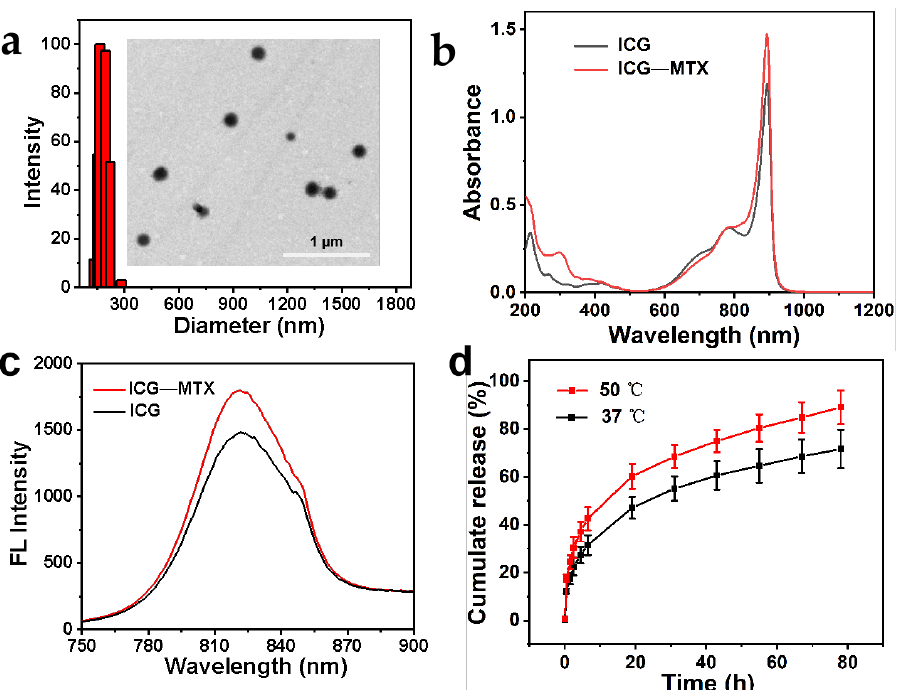
Figure 2. ( a ) ICG — MTX TEM pictures and DLS data. ( b ) ICG — MTX and ICG ’s ultraviolet, visible, and infrared absorption spectra. ( c ) Fluorescence spectra of ICG — MTX and ICG. ( d ) ICG — MTX